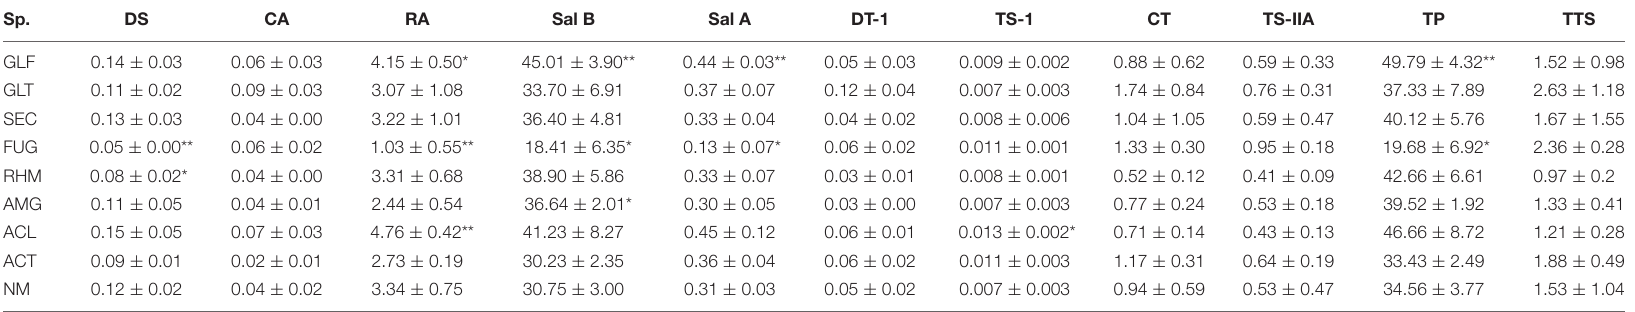
*Means that there was a significant difference (p < 0.05) between the group compared with NM. **Means that there was highly significant difference (p < 0.01) between the group compared with NM. Data are mean ± SD (n = 6).